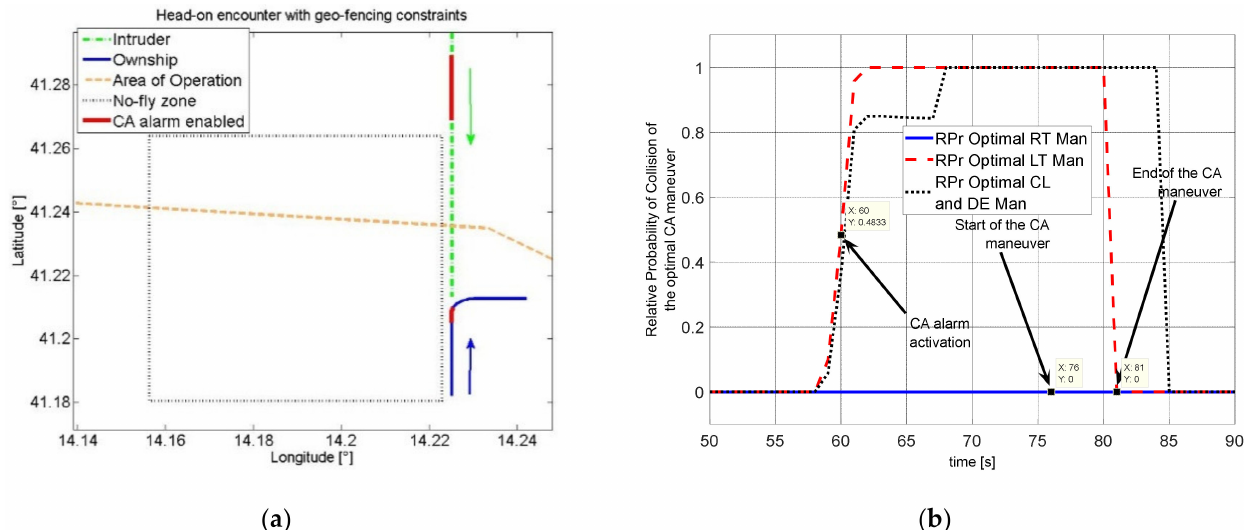
Figure 15. Head-on scenario in the presence of a no-fly zone near the border of the area of operation. ( a ) Trajectories; ( b ) RPr Time